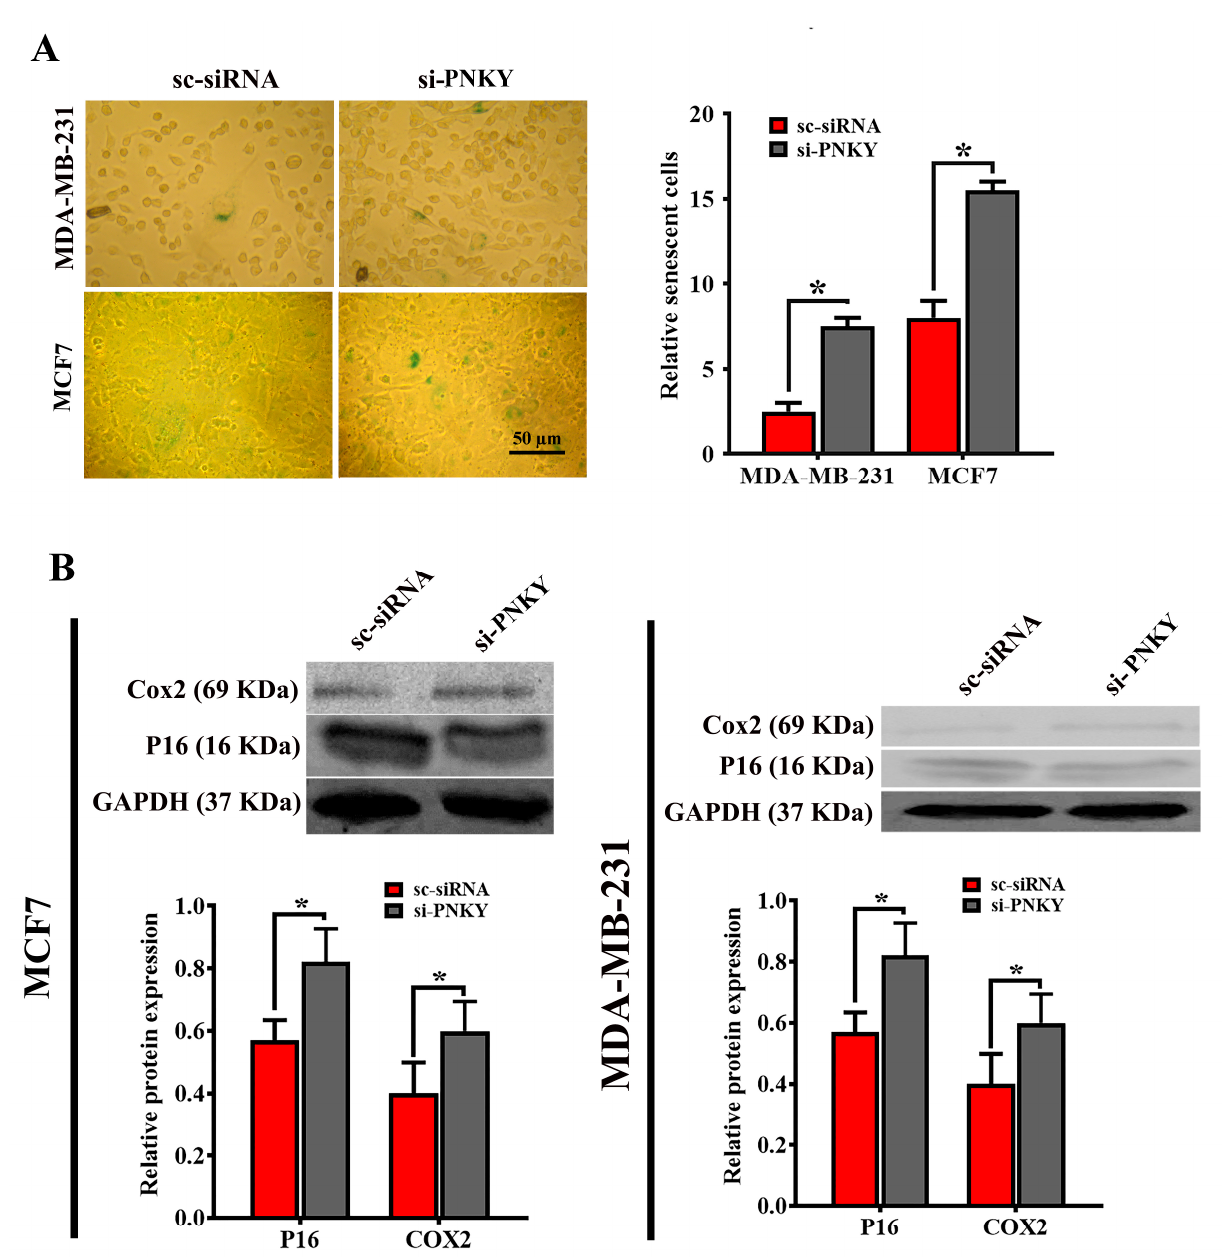
Figure 5. The downregulation of PNKY promotes cellular senescence in MCF7 and MDA-MB- 231 cells. ( A ) The number of SA- β -gal positive staining breast cancer cells significantly increased following PNKY downregulation. ( B ) Western blotting analysis showed that P16 and COX2, two well- known senescence markers, were significantly upregulated in breast cancer cells when PNKY was suppressed. The values shown represent the mean ± SE. * p value <